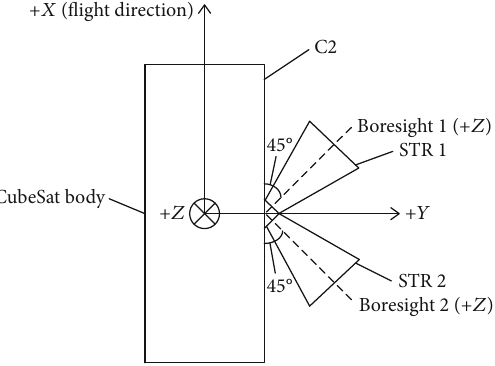
Figure 2: Mounting diagram of two